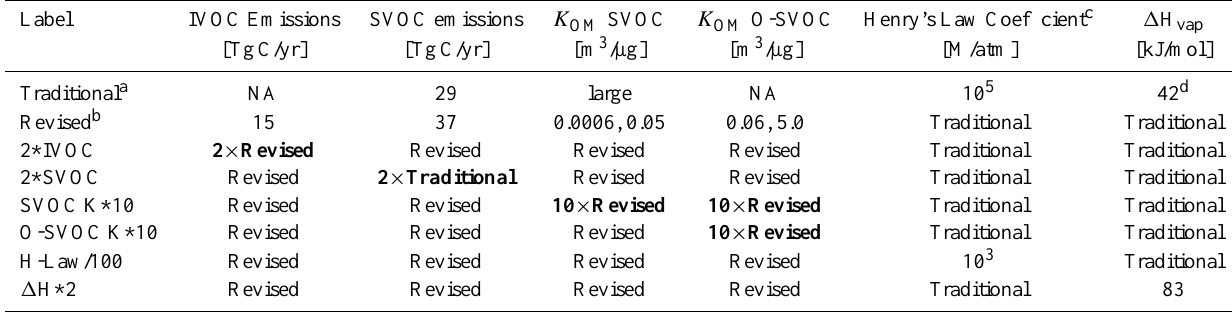
Table 6. Sensitivity tests with GCM meteorology at 4 ◦ × 5 ◦ .